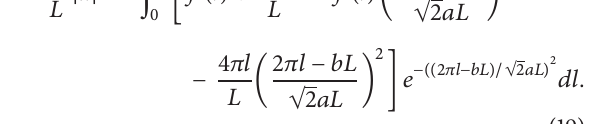
Figure 6: Definition of the subintegrals 𝑇1 – 𝑇6